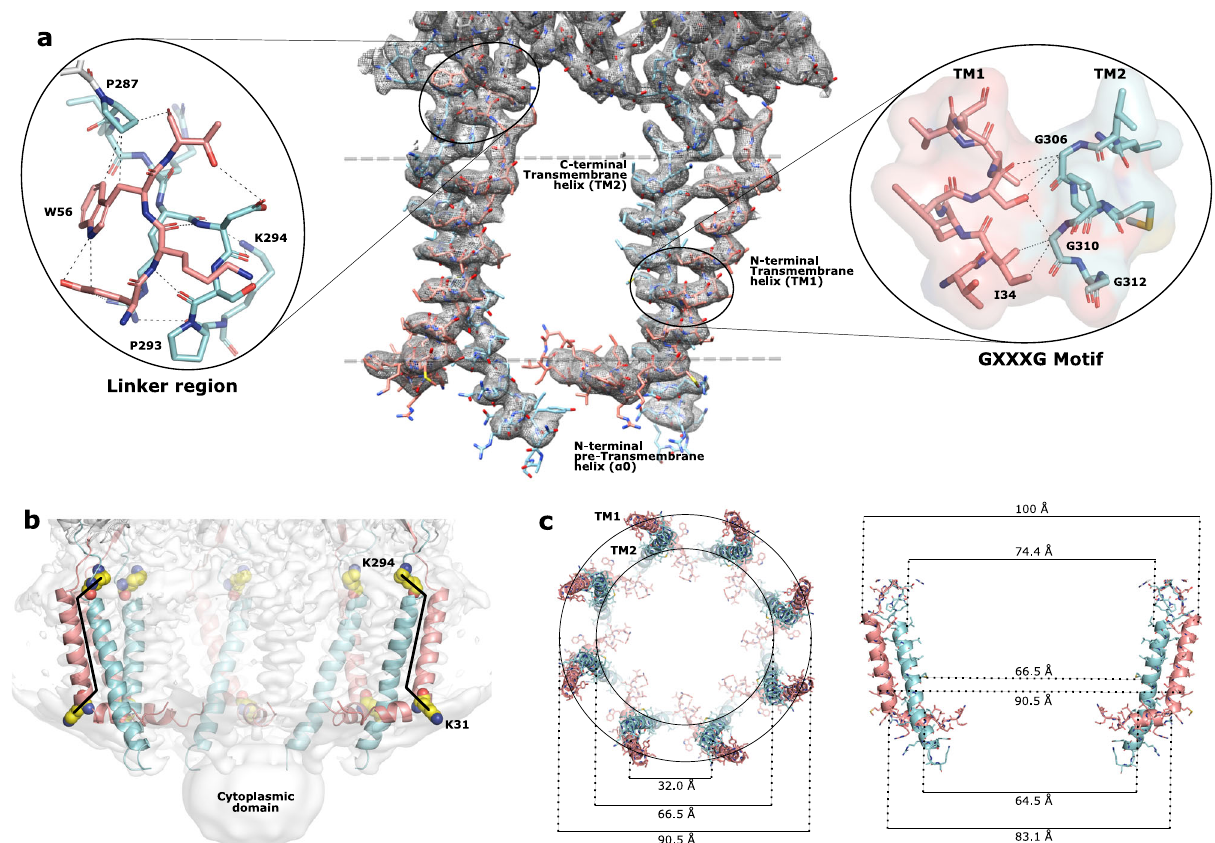
Fig. 4 The transmembrane domain. a The C8-symmetrized map and model of the transmembrane domain of two adjacent protomers. Gray dashed lines represent the position of the membrane. Left circle: zoomed area of the linker region. Right circle: zoomed region around the conserved GXXXG motif. b The C8-symmetrized map (white) and model showing the transmembrane chamber and cytoplasmic hub. Positions of the conserved K294 and K31 (spheres) are displayed. To visualize the interior of the chamber three protomers have been removed. The black line represents a potential stabilizing brace created by the two lysines on opposite sides of each transmembrane pillar. c Dimensions of the transmembrane chamber. Left: view looking down from the periplasmic side sliced to the top of the TM domain. Right: two opposing protomers with distances to measure the diameter of the chamber at different levels within the